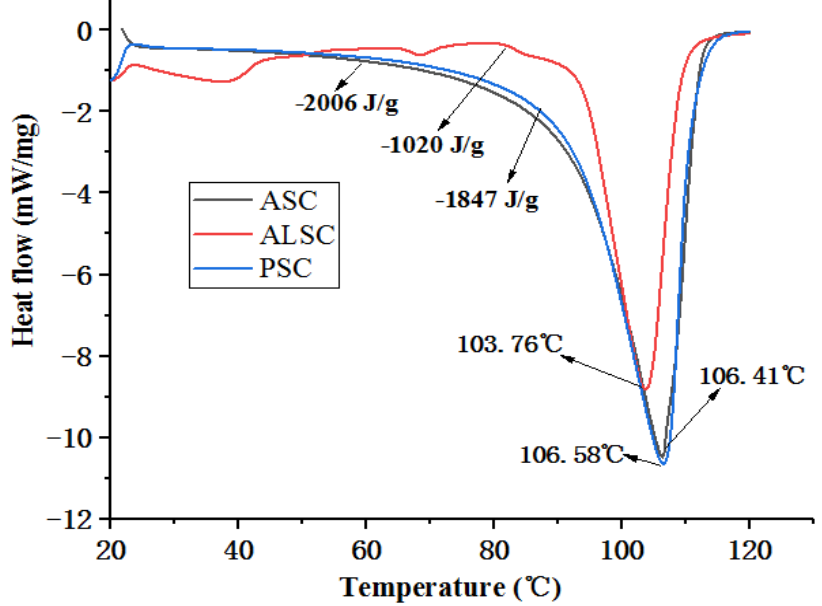
Figure 3. Differential scanning calorimetry of ASC, ALSC and PSC.